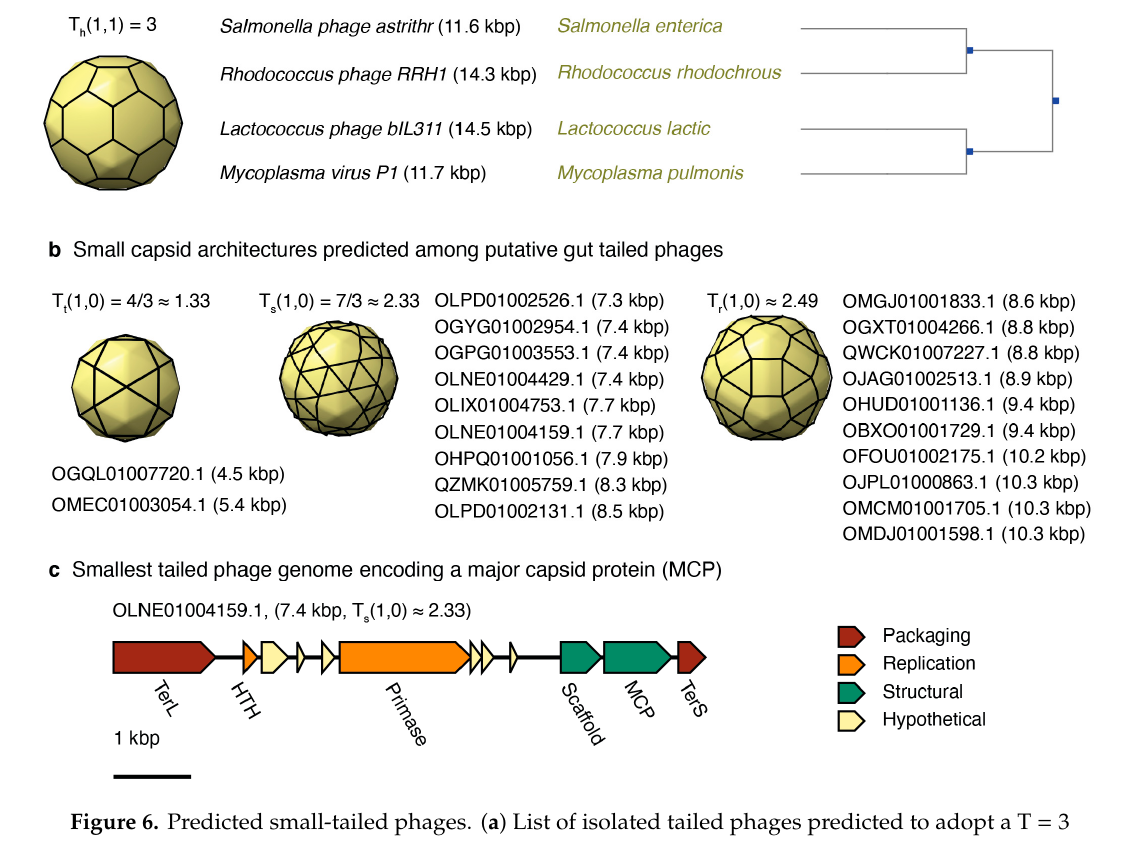
Figure 6. Predicted small-tailed phages. ( a ) List of isolated tailed phages predicted to adopt a T = 3 capsid architecture. The panel displays the phage name, genome length, host, and hosts’ phylogenetic tree. ( b ) List of putative gut tailed phage genomes predicted to adopt T ≤ 3 capsid